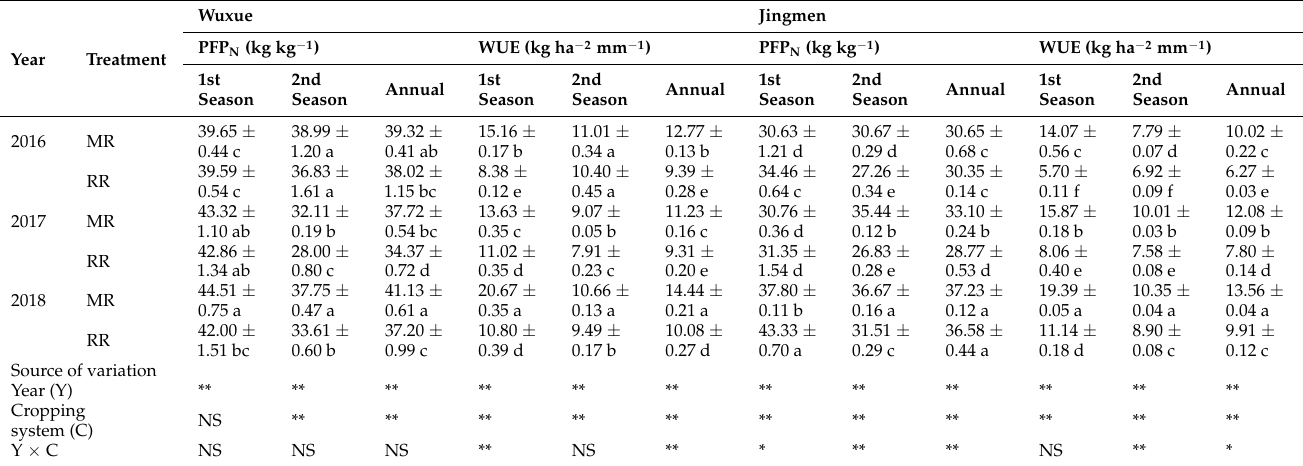
Table 9. N partial productivity from applied N (PFP N ) and water use efficiency (WUE) in the MR and RR cropping systems from 2016 to 2018 at Wuxue and Jingmen.